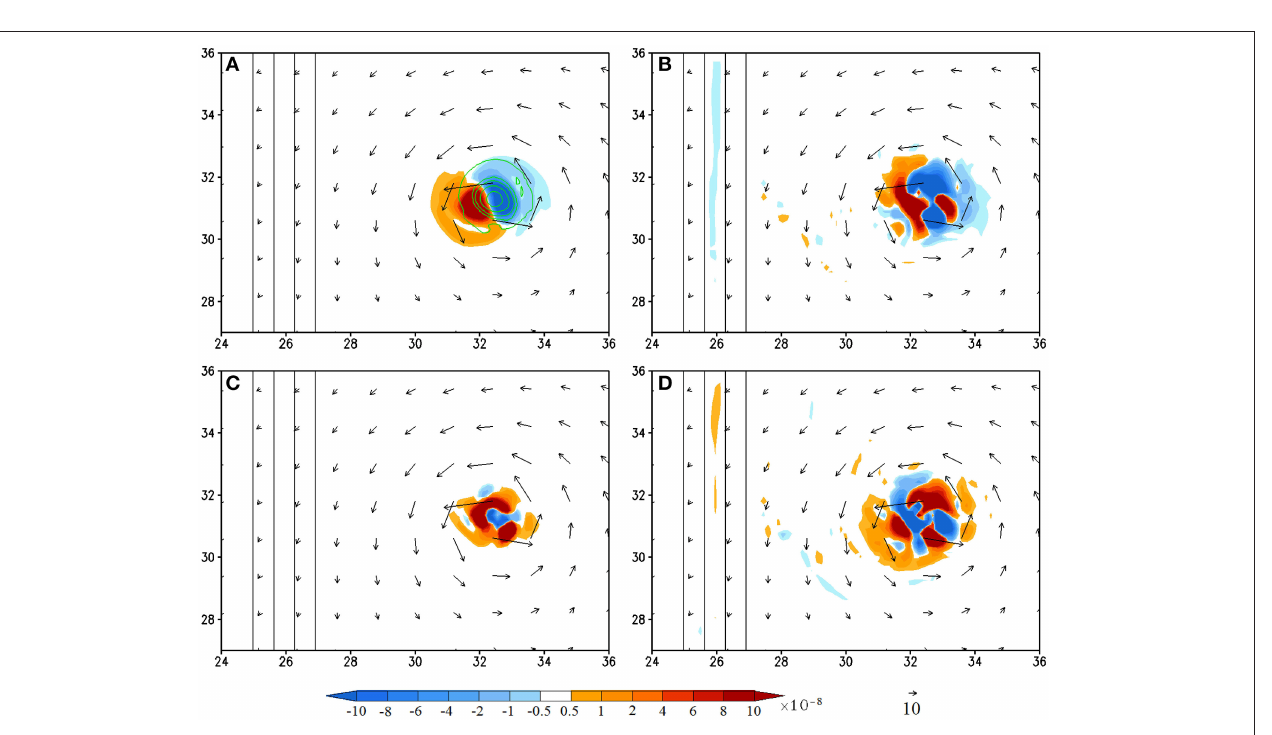
FIGURE 4 | (CNTL/A2) Vorticity budget analysis averaged for the 950–500 hPa layer at 132h (shaded): (A), vorticity tendency (VT); (B), horizontal vorticity advection; (C), relative vorticity stretching, and (D), residual term. The vertical vorticity field is depicted by contours (0.0001, 0.0005, 0.001, 0.002, 0.003 s − 1 ) in (A) . The residual term is obtained by subtracting (A) by the sum of (B,C) , vertical advection, planetary vorticity stretching, and tilting terms. The last three terms are not shown since their magnitudes are negligible compared to terms (A–C) . The units of the coordinates in the x and y directions are